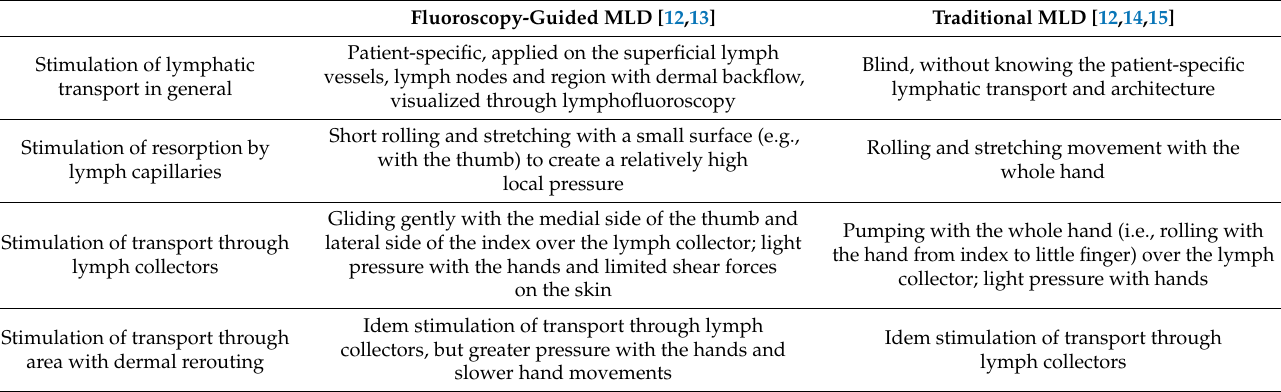
Table 1. Comparison of the characteristics of fluoroscopy-guided MLD and traditional